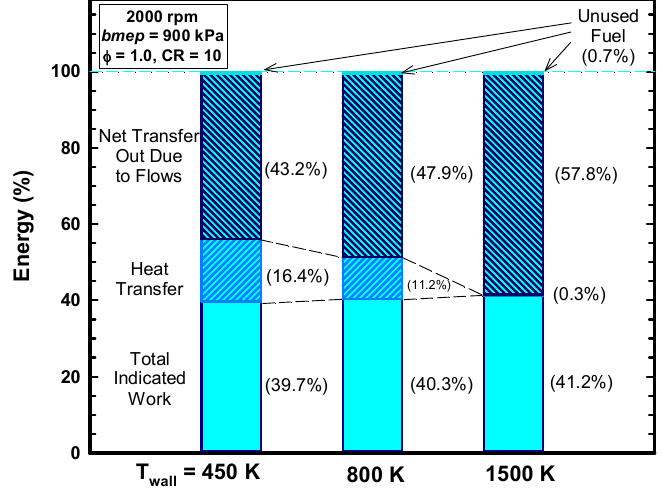
Figure 9. The fuel energy distribution for three cylinder wall temperatures.